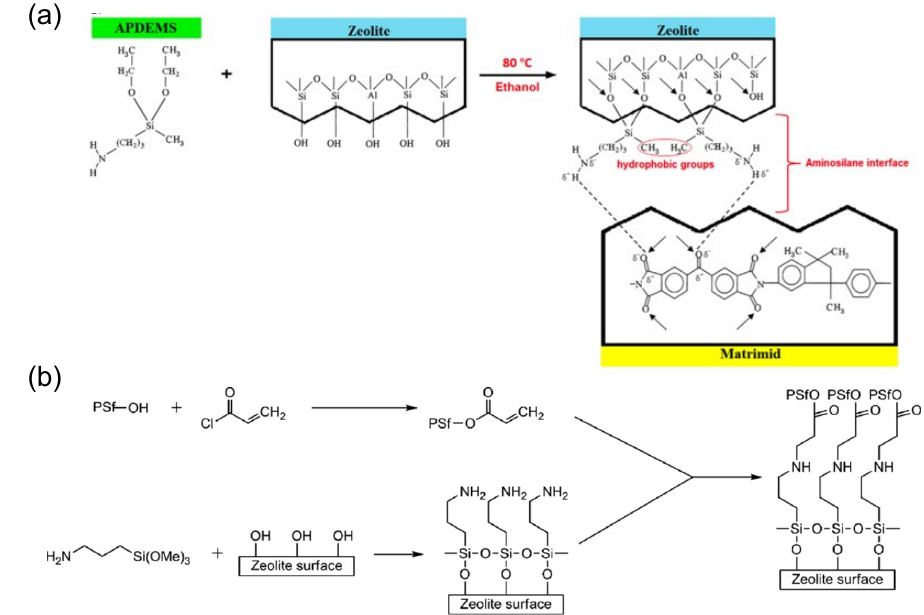
Figure 4. ( a ) The grafting reaction between APDEMS and the zeolite surface. Reprinted with permission from [74], copyright 2015 Elsevier. ( b ) Reaction scheme of covalently bonded zeolite with acrylate modified polymer. Reprinted with permission from [75], copyright 2010 Elsevier.